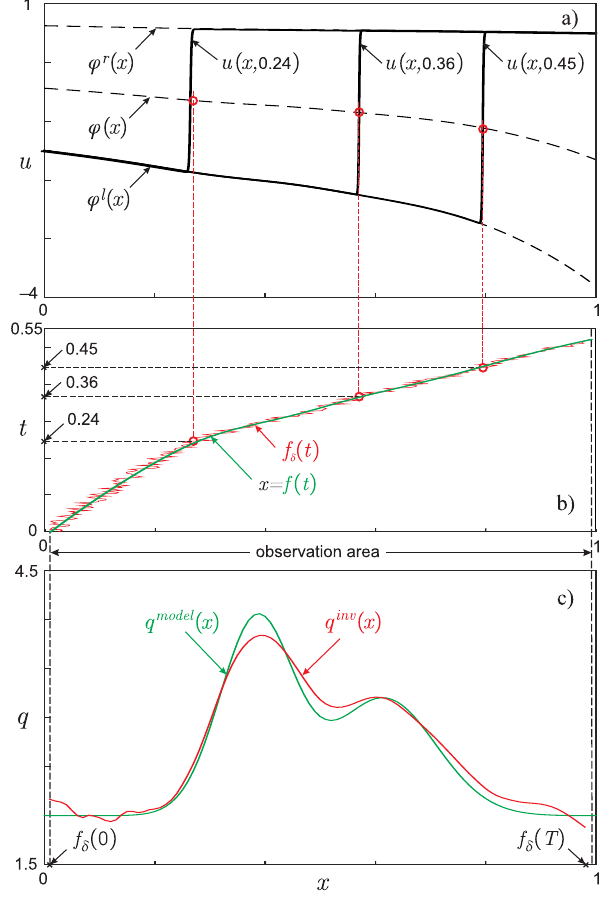
Figure 4. ( a ) Solution of the problem (1) at several fixed moments of time t ; ( b ) exact model function f ( t ) and noisy function f δ ( t ) ; ( c ) result of recovering the function q inv ( x ) for δ =